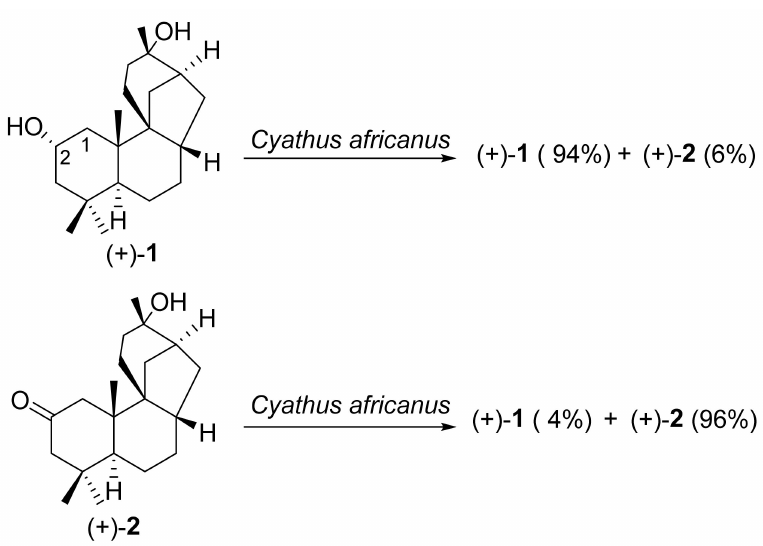
Figure 15. Stemodane diterpenoids biotransformation